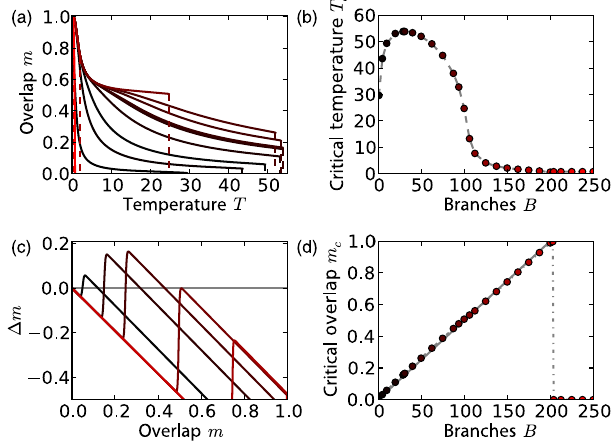
FIG. 7. Memory performance in dependence of the number B of dendritic branches. Parameters are the same as in Fig. 5, with D ¼ 0 . 6 and θ ¼ 0 . 005 . Branch numbers B are color-coded from black to red; cf. (b) and (d). (a),(c) Results for a few selected values of B . (a) The overlap curves m ð T Þ with α ≈ 0 are computed for varying numbers B of branches. (b) The critical temperature T c depends nonmonotonically on B and is maximal 30 (dashed line and circles). For a fixed temperature for B T; opt ¼ T ¼ 25 , (c) shows Δ m whose 0 s provide the solutions for m [Eq. (30)] and whose maxima display a nonmonotonical depend- ency on B . (d) The critical overlap m c (dotted line and circles) grows approximately linearly with B as indicated by the linear function m c ¼ θ B (solid line) and jumps to zero at m c ≈ 1